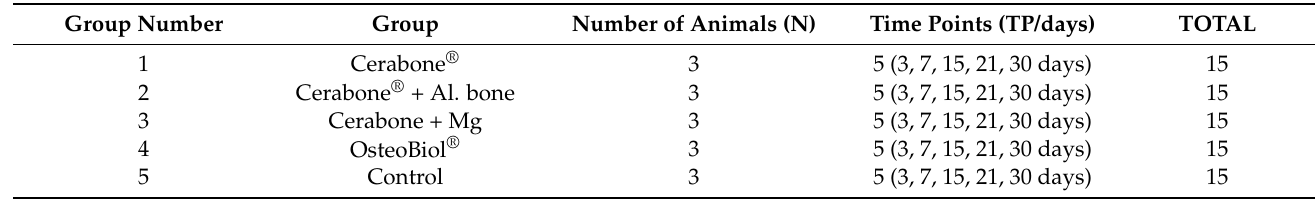
Table 2. Experimental